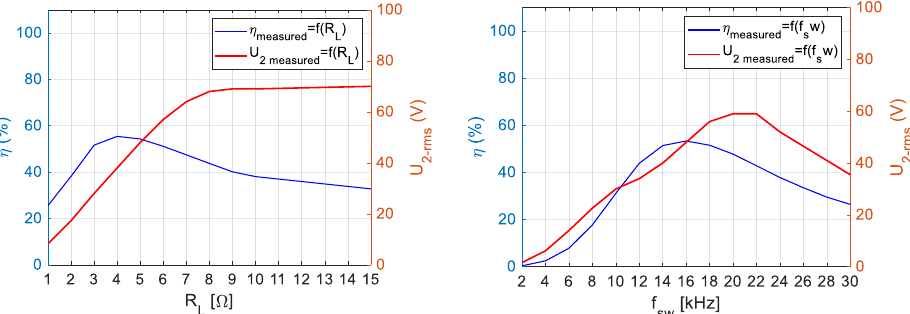
Figure 9. Measurements of system efficiency and secondary voltage as a function of load ( left ) and